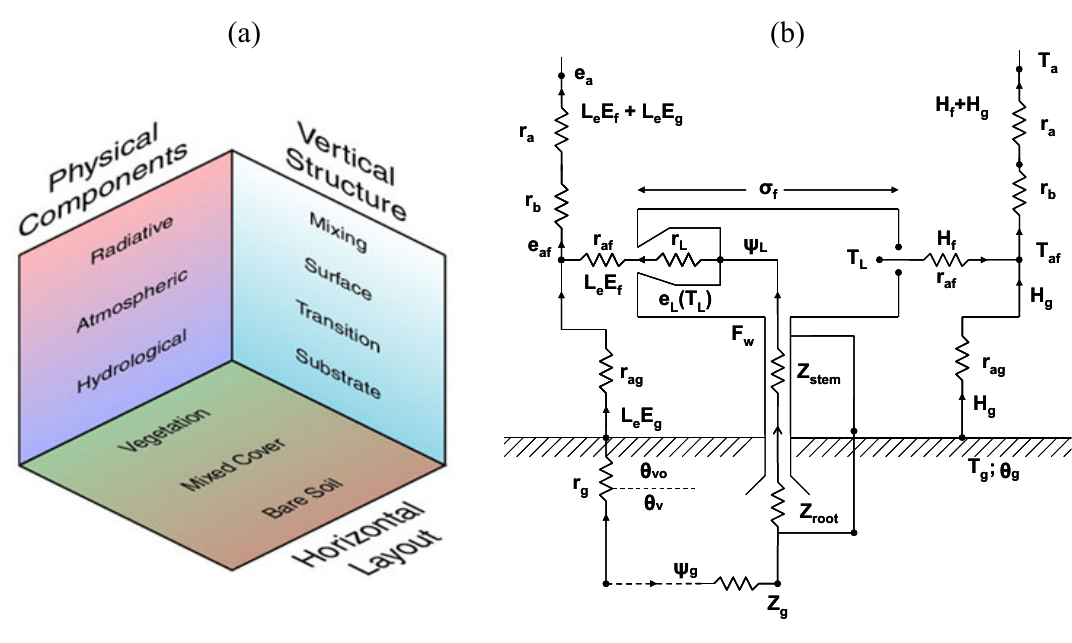
Figure 2. The figure on the left (a) depicts the different facets of the SVAT model architecture (figure adopted from SimSphere user’s manual (available at https://courseware.e-education.psu.edu/simsphere/workbook). The figure on the right (b)